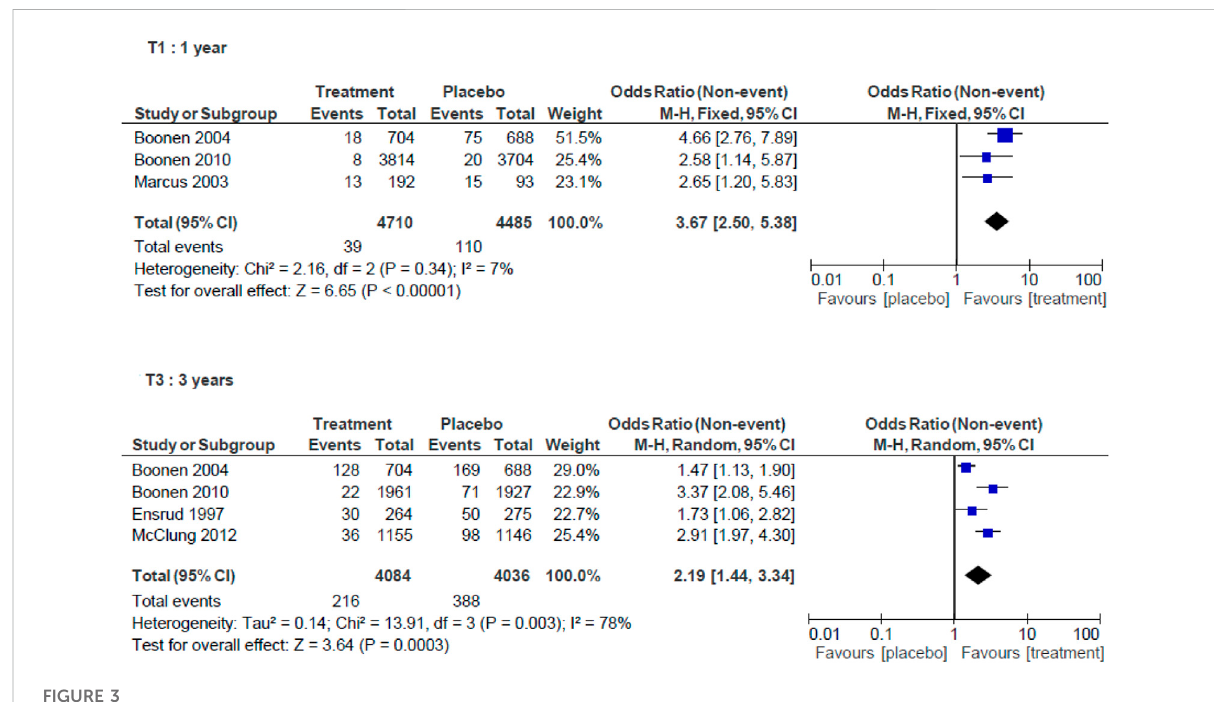
FIGURE 3 Meta-analysis of vertebral